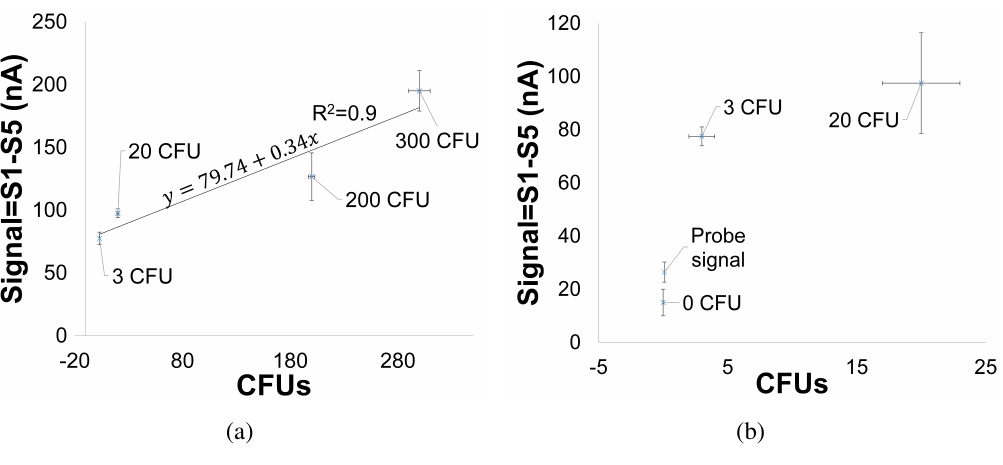
Figure 8. Relative DPV signals (S1-S5) corresponding to varying concentrations of E. coli O157:H7 in seeded 100 mL PBS buffer